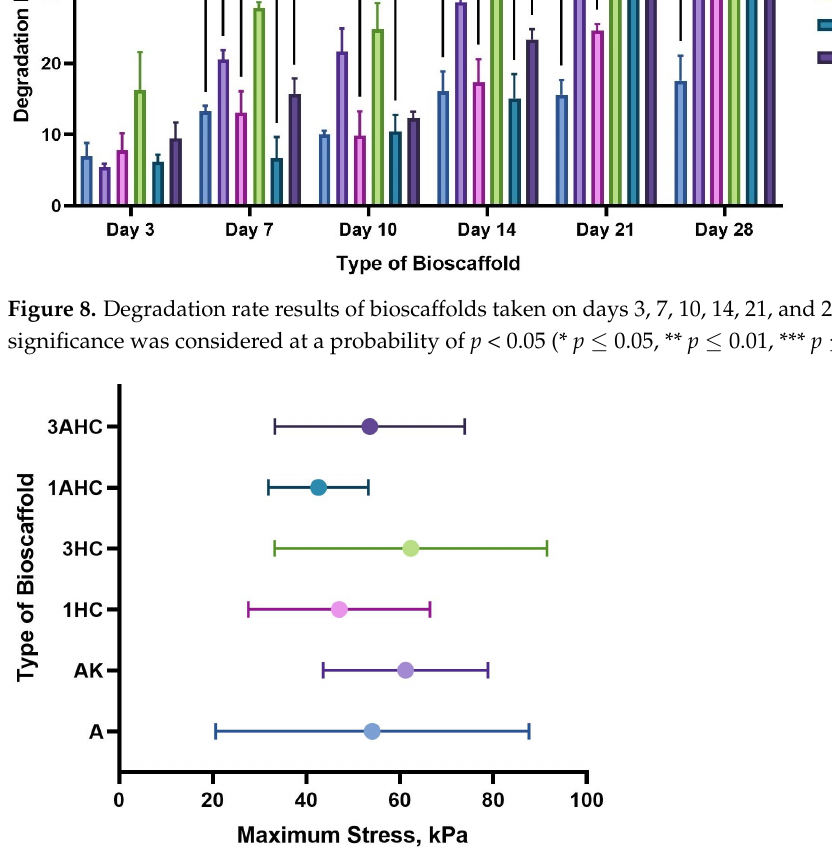
Figure 9. Tensile strength results of Figure 9 . Tensile strength results of bioscaffolds.